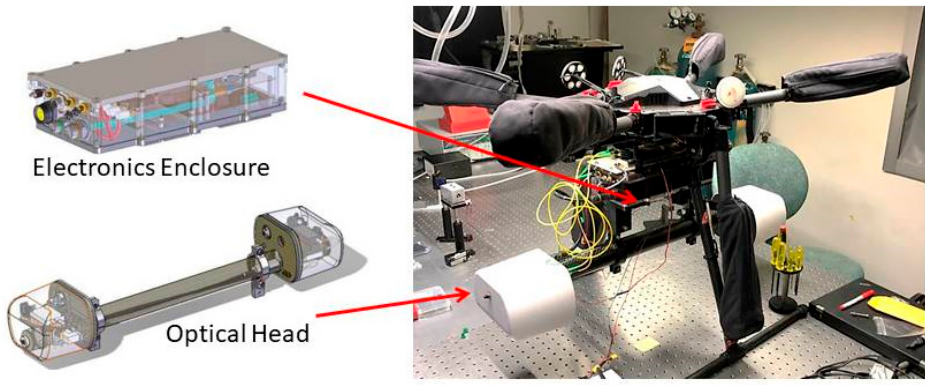
Figure 2. Illustration of sensor mounting to sUAS. Table 1. Flight specifications of sUAS with methane sensor.